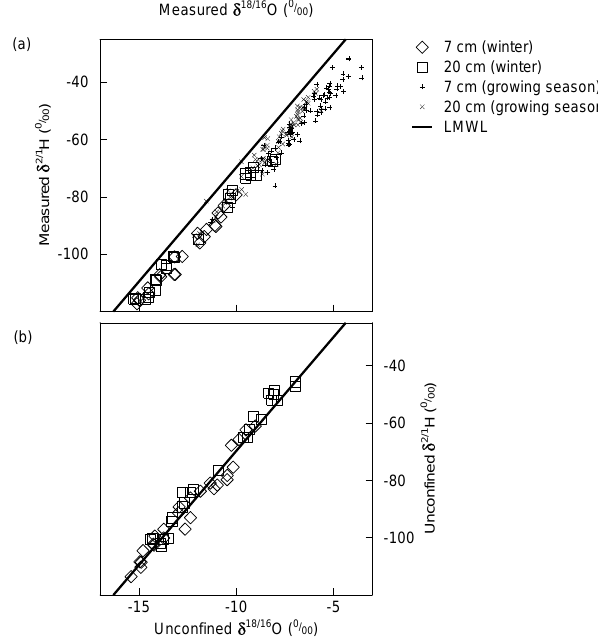
Figure 6. Isotope composition of soil water at 7 and 20cm depth (winter season: N = 26; growing season: N = 48). (a) Mea- sured total soil water. (b) Estimated unconfined water. The solid line denotes the local meteoric water line ( N = 79; y = (8.0 ± 0.2) x + (10 ± 2); R 2 =